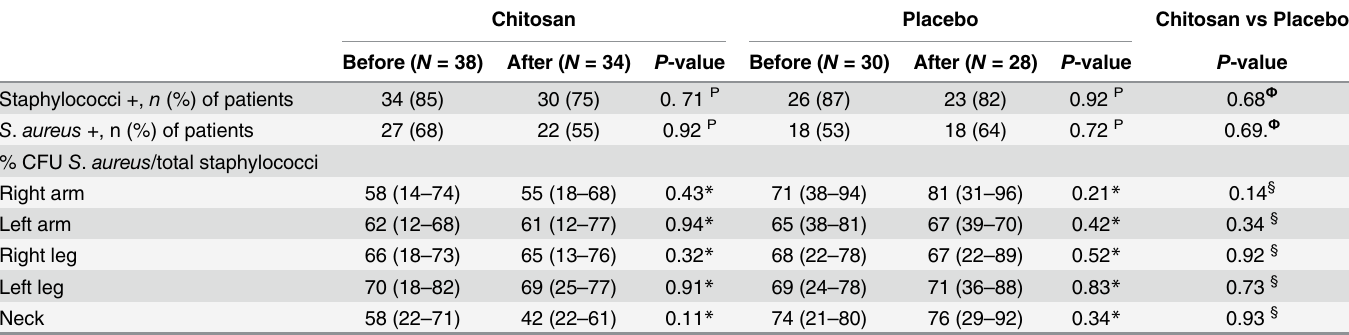
Table 3. Skin microbiological profile in chitosan and placebo groups before and after intervention. Chitosan Placebo Chitosan vs